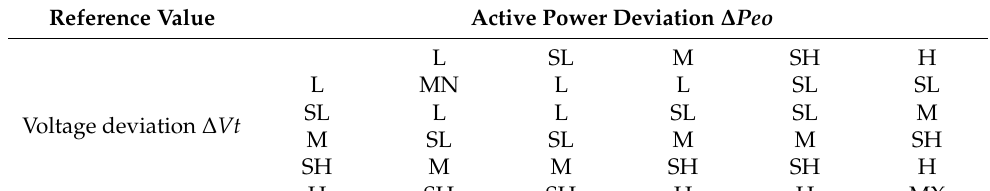
Figure 3. Mode selection of the amplitude limiter. Table 1. Fuzzy Control Rules for Amplitude Limiter.